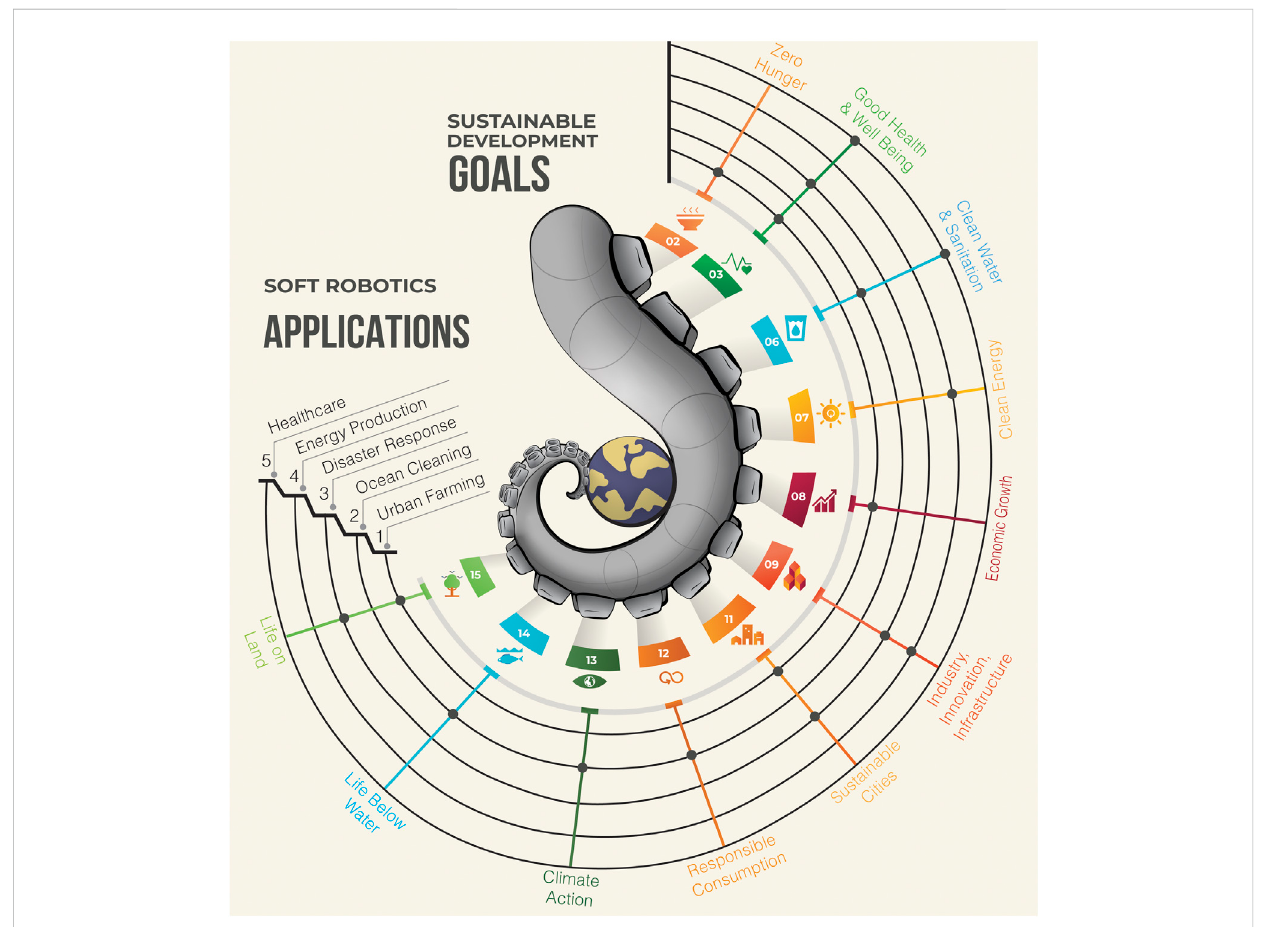
FIGURE 1 Illustration of an octopus arm holding the Earth with suction cups, symbolizing the boundless potential to support the United Nations ’ Sustainable Development Goals. The concentric lines surrounding the octopus arm represent fi ve fi elds of soft robotics applications: urban farming, ocean cleaning, disaster response, energy production, and healthcare. The reader can understand the strategic mapping of SDGs to soft robotic applications. For example, soft robotics for urban farming aligns with SDGs 2, 3, 8, 11, and 15 (black dots). This correlation between SDGs and soft robot applications enhances our comprehension of the signi fi cance of future robots in promoting sustainability to enable climate transition